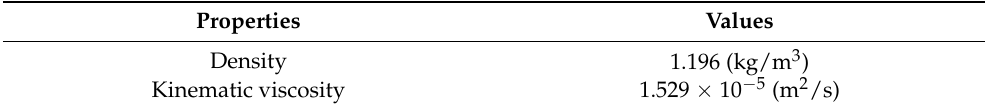
Table 1. Initial conditions of the CFD simulations for the investigation of the transport phase of the measurement course.